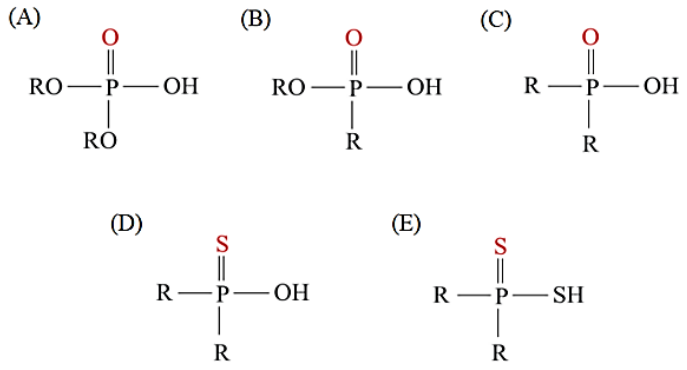
Figure 2. Chemical structures of the acidic phosphorus extractants: ( A )—phosphoric acid, ( B )—phosphonic acid, ( C )—phosphinic acid, ( D )—monothiophosphinic acid, and ( E )—dithiophosphinic acid, adapted from